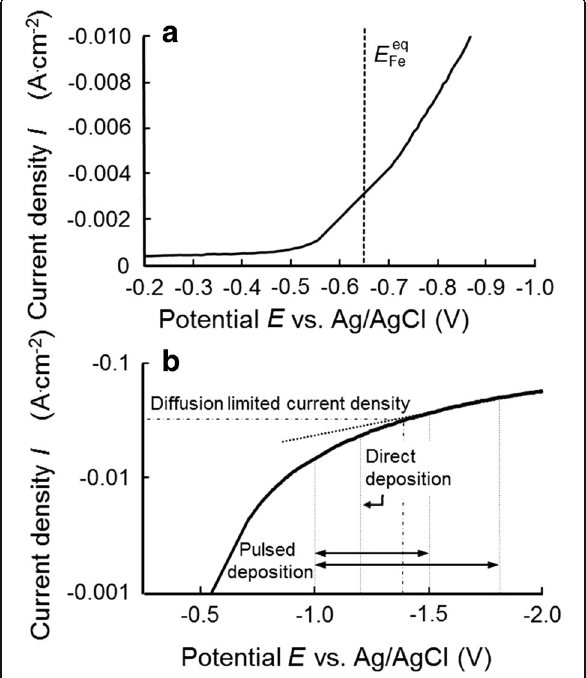
Fig. 2 a Cathodic polarization curve from a 0.05 mol L − 1 FeSO 4 electrolyte at 30 °C and b Tafel plot of the polarization curve. Scan rate was fixed to 30